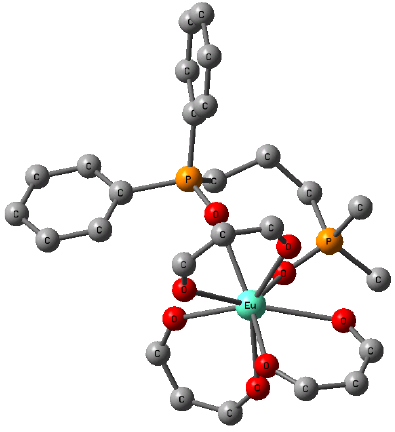
Figure 18. The optimized geometry of simplified Eu(III) complexes with three  -diketonates and non-symmetric phosphine oxides (H atoms are